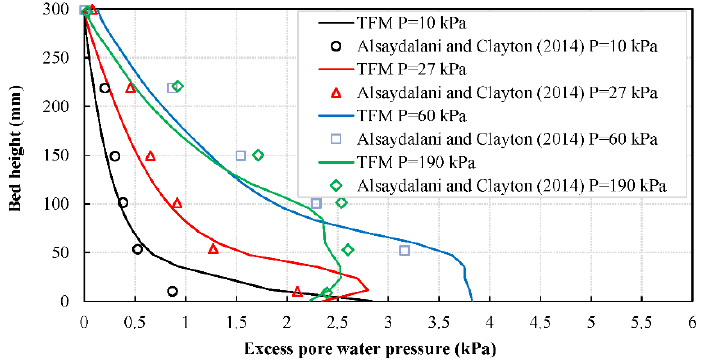
Figure 3. A comparison between the pressure distribution along the bed centerline from TFM simulation and the experimental results for upstream pressures of 10, 27, 60, and 190 kPa and orifice opening of 0.62 mm.